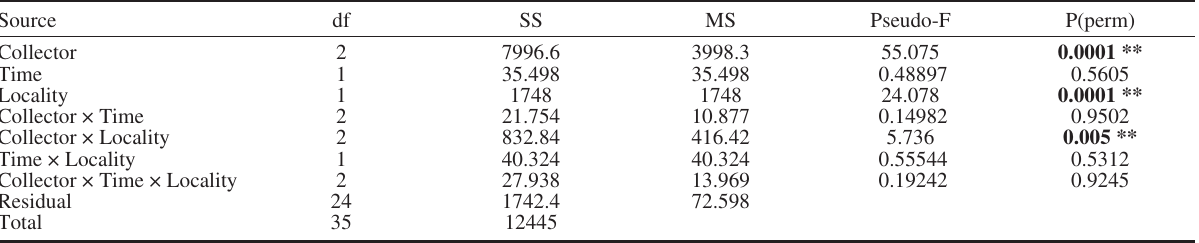
Table 1. – Results of the three-way permutational analysis of variance (PERMANOVA) performed to identify significant differences in the number of P. lividus settlers between the factors ‘Collector’, ‘Time’ and ‘Locality’ (Abades and Tossa de Mar). Significant results are shown in bold (** p<0.01).